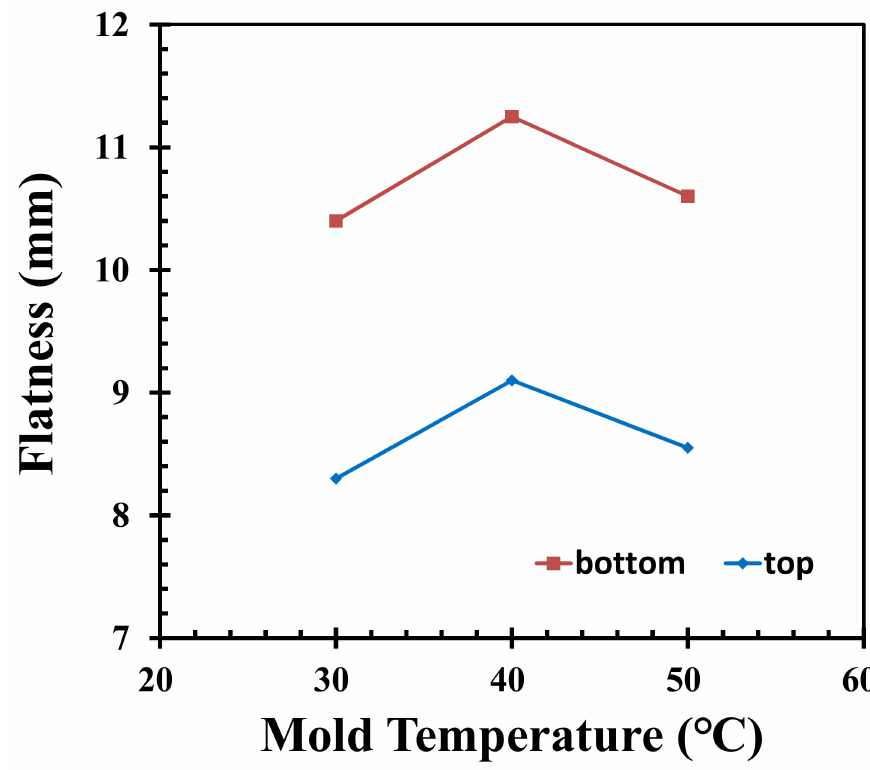
Figure 4. Flatness of the pallet when adjusting the mold